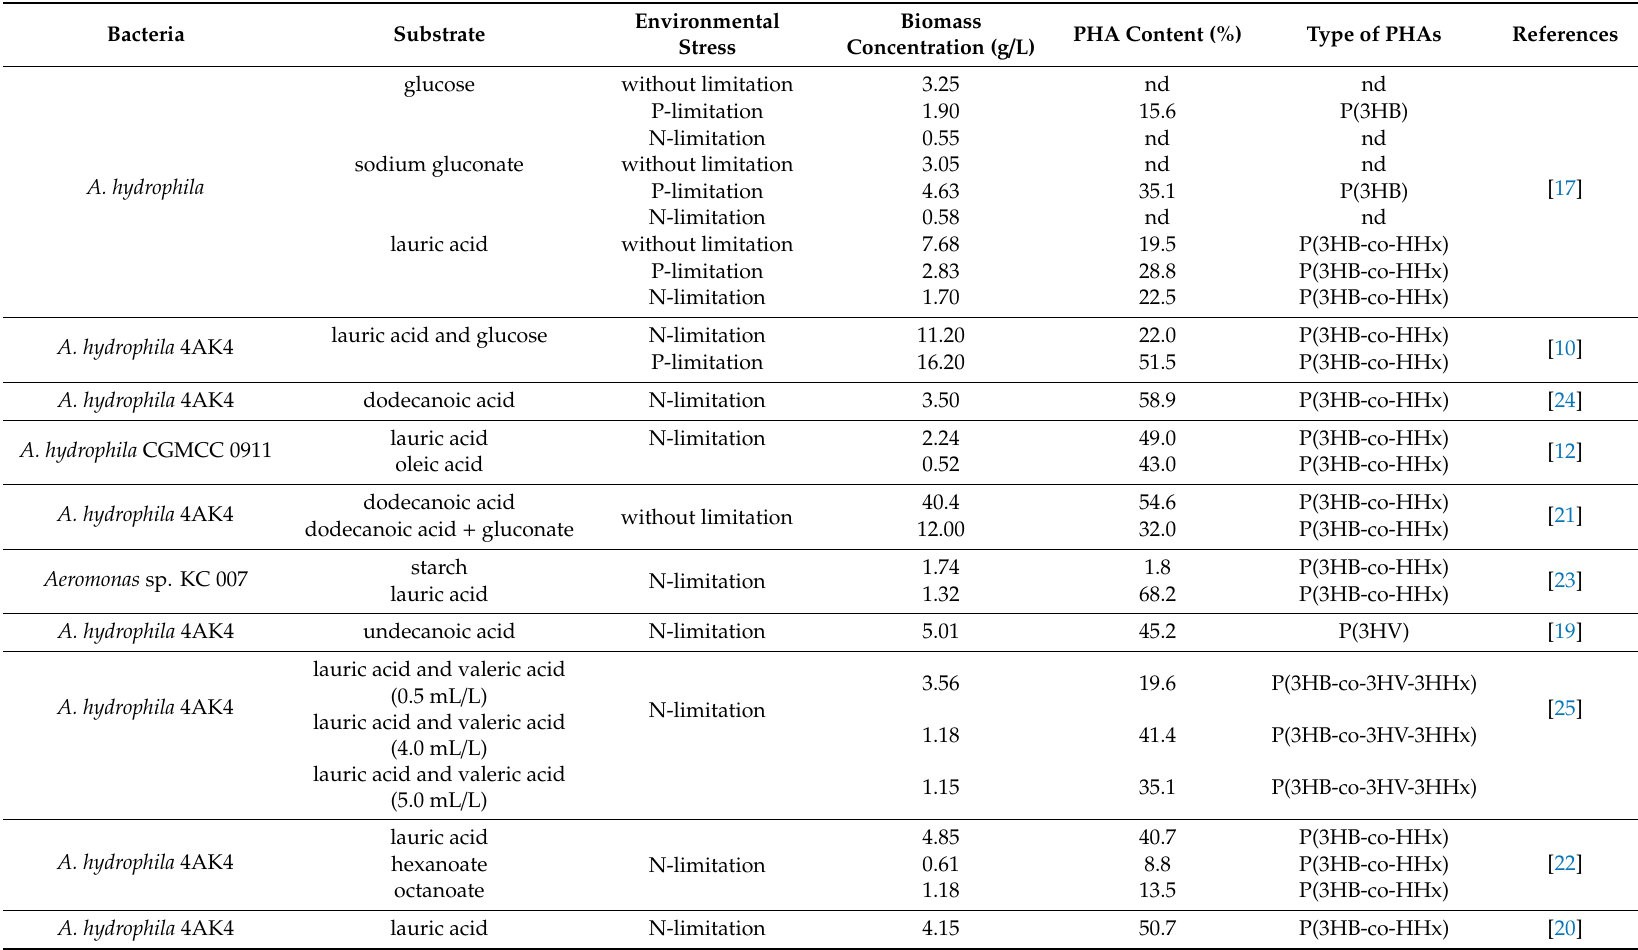
Table 1. An overview of microbial synthesis of PHAs by Aeromonas sp. grown on di ff erent carbon